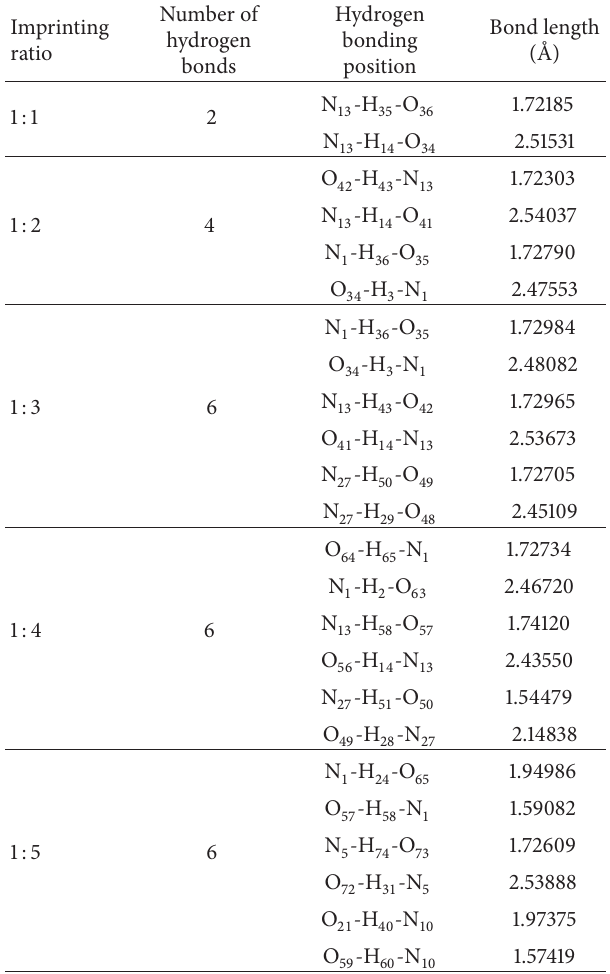
Table 3: The number of hydrogen bonds, location, and the bond length under different proportions.